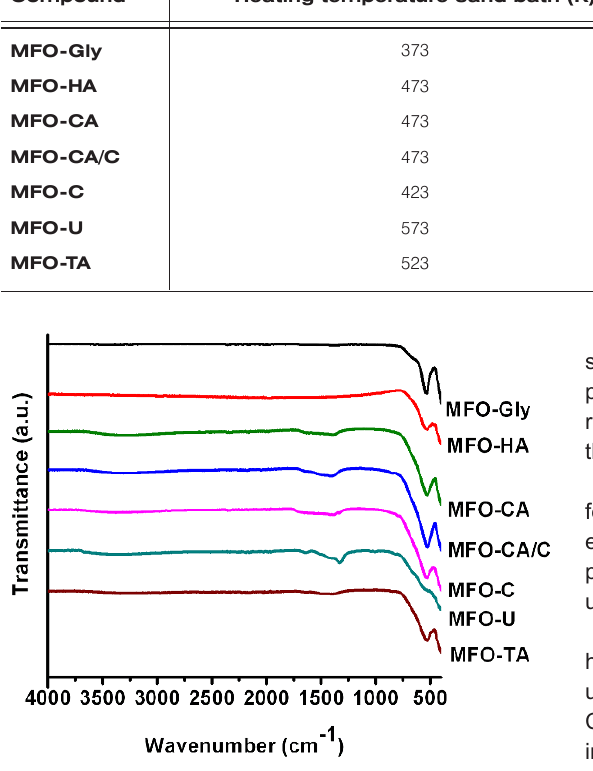
Table 1. Temperature sand bath and temperatures during auto-ignition for MFO synthesized by sol-gel auto-combustion. Compound